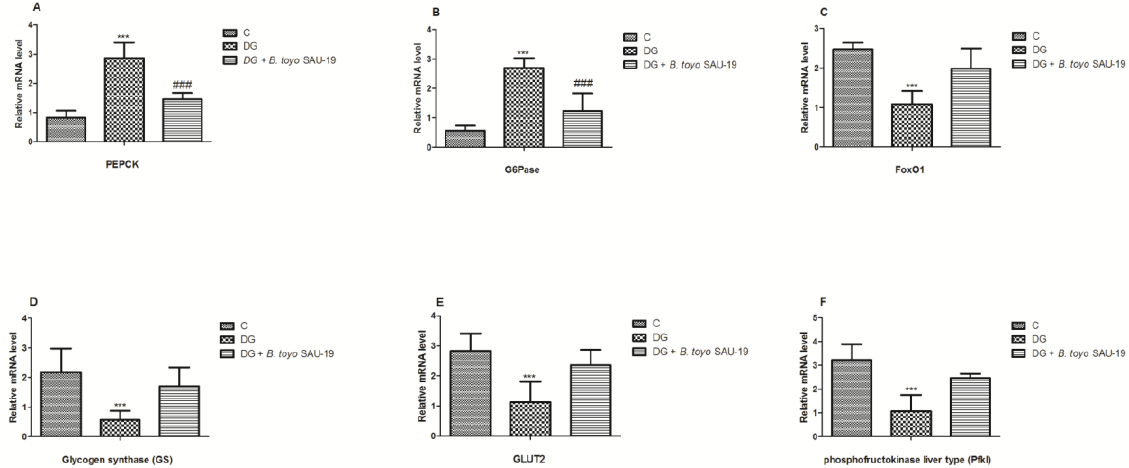
Figure 9. Effects of Bacillus toyonensis SAU-19 on the relative mRNA expression of glucose and glycogen synthesis-related genes in HFD/STZ-induced T2DM mice. ( A , B ) mRNA expression levels of genes related to glucose synthesis. ( C – F ) mRNA expression of genes related to glycogen synthesis. Values are shown as mean ± Sd. *** p < 0.05, DG compared with the control (C) and B. toyo SAU-19 groups. ### p < 0.05, B. toyo SAU-19 compared with the control (C) group ( n = 6).